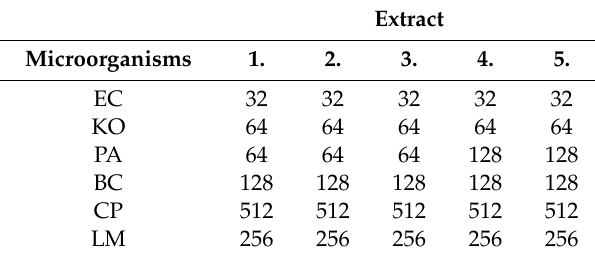
Table 2. Minimal inhibition concentration of rose fruit extract in µ g / mL.